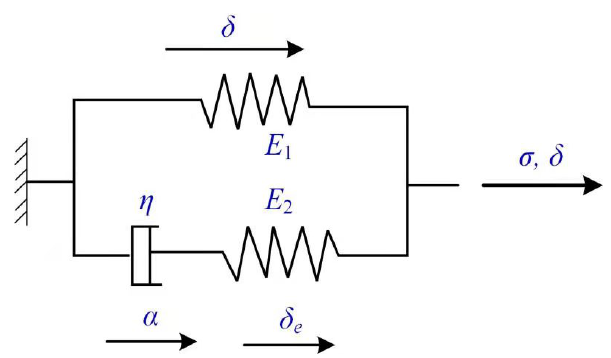
Figure 24. The viscoelastic model by Musto and Alfano [100].